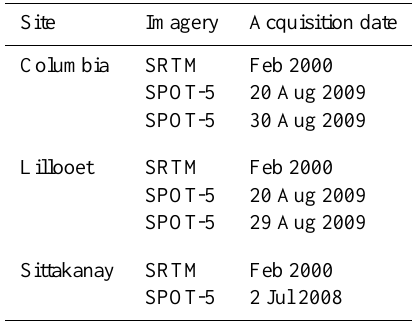
Table 4. Imagery used in geodetic mass change